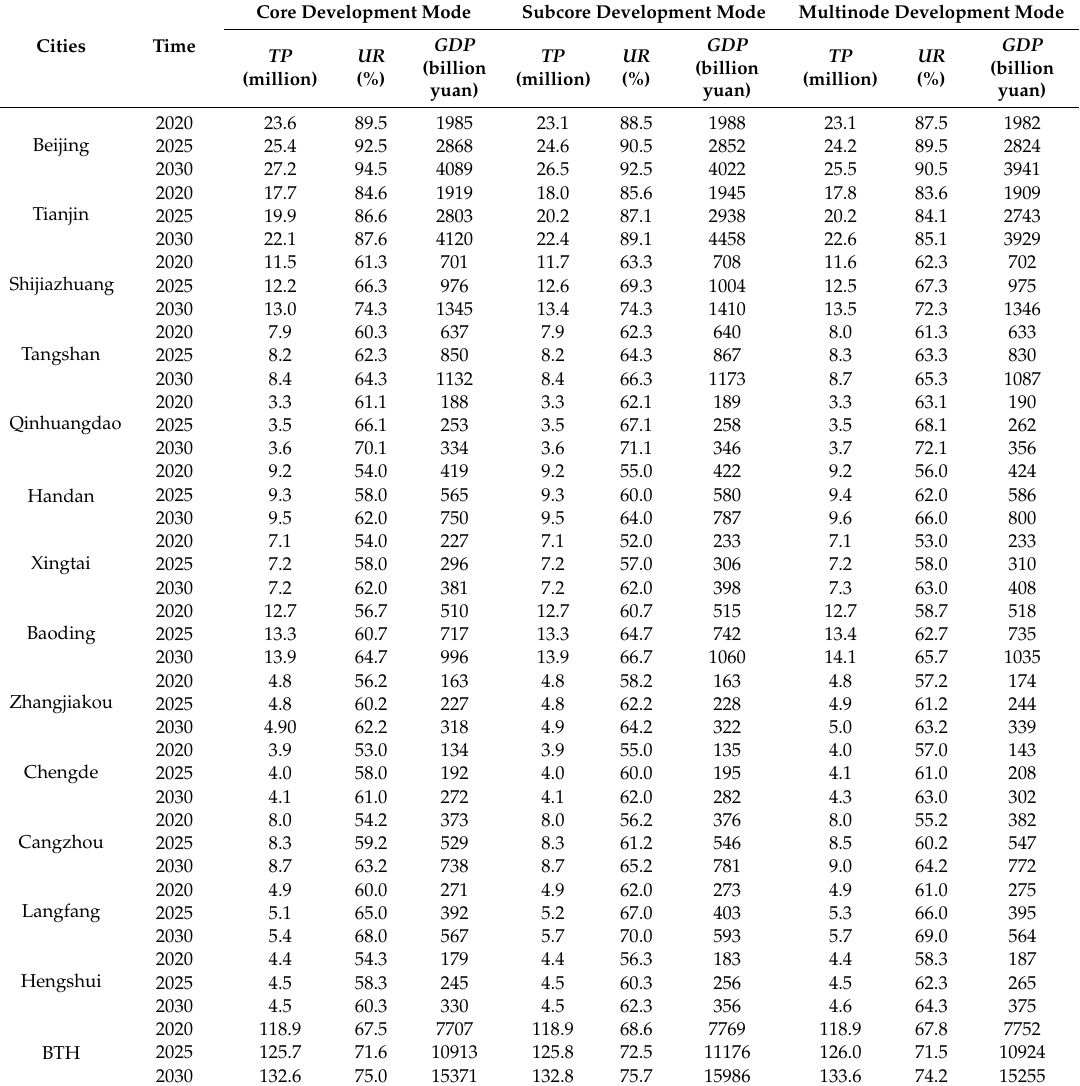
Table 2. Urbanization development under di ff erent scenarios in BTH urban agglomeration.